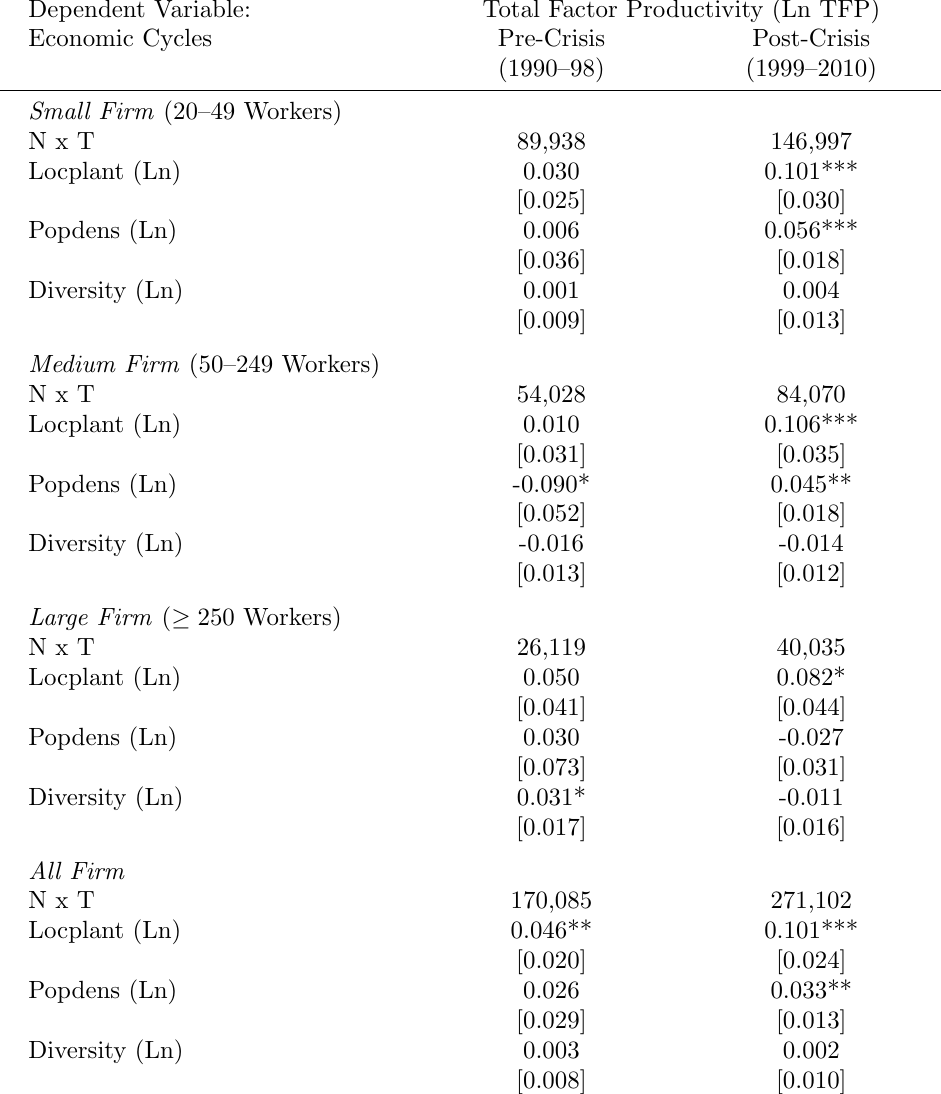
Table 3: Agglomeration Externalities by Plant Size over Economic Cycles Dependent